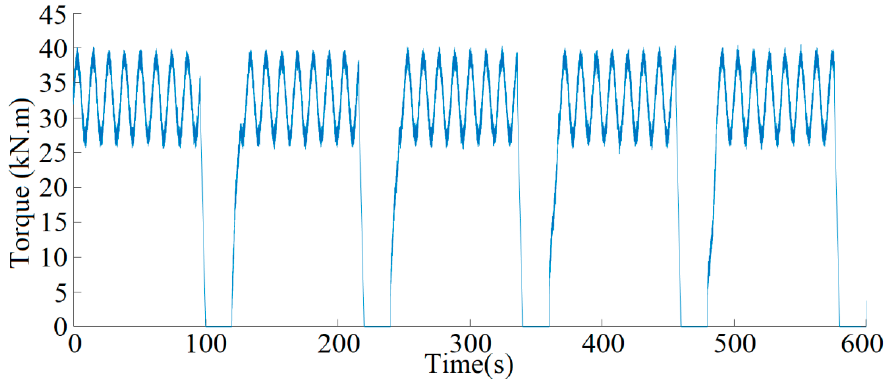
Figure 5. Generator input mechanical torque availability from the kite and tether.